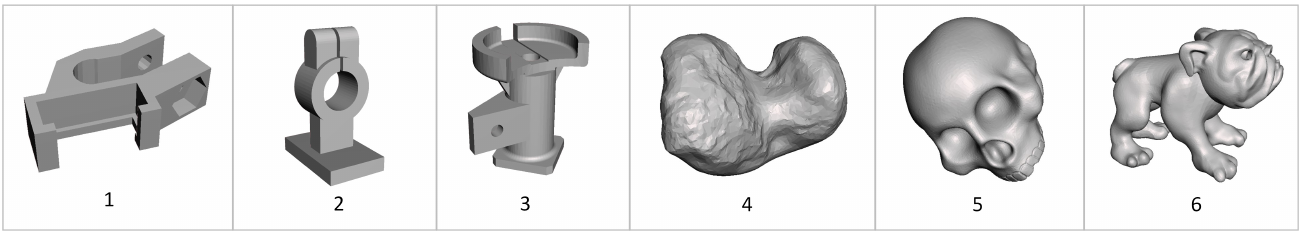
Figure 7. STL models of six FDM parts.